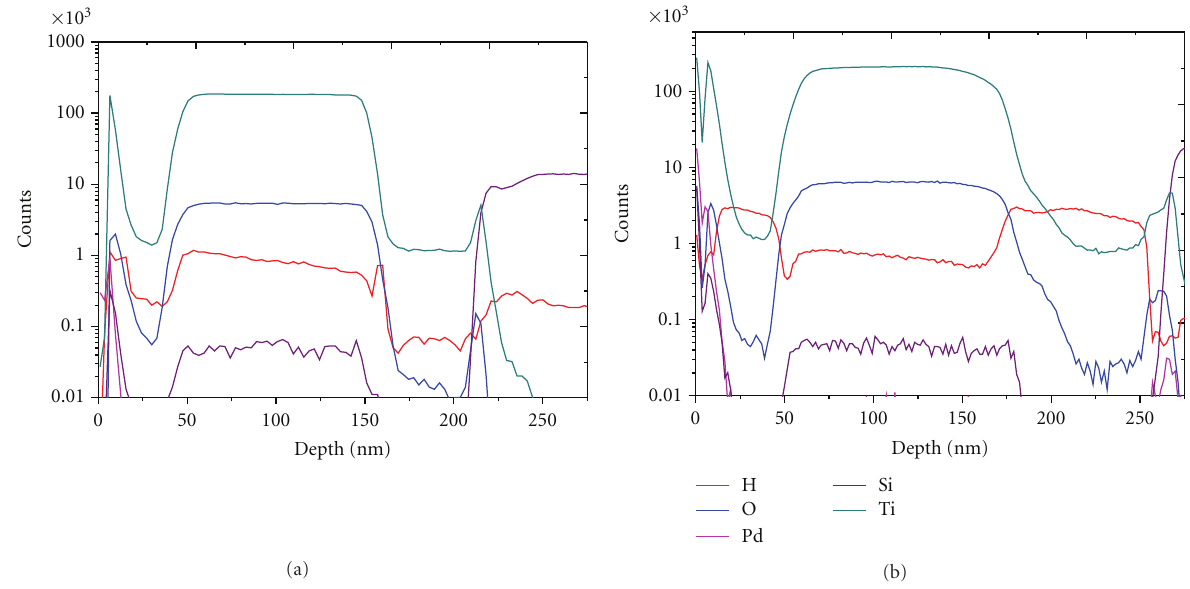
Figure 5: SIMS profiles for the sample Pd/Ti/TiO 2 /Ti/Si before (a) and after (b) hydrogen charging.